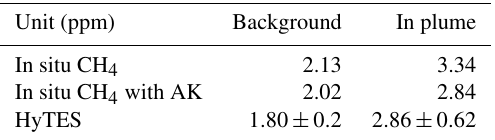
Table 1. CH 4 vertical average below HyTES flight height. In situ CH 4 with AK is the in situ CH 4 measurement convolved with the HyTES averaging kernel